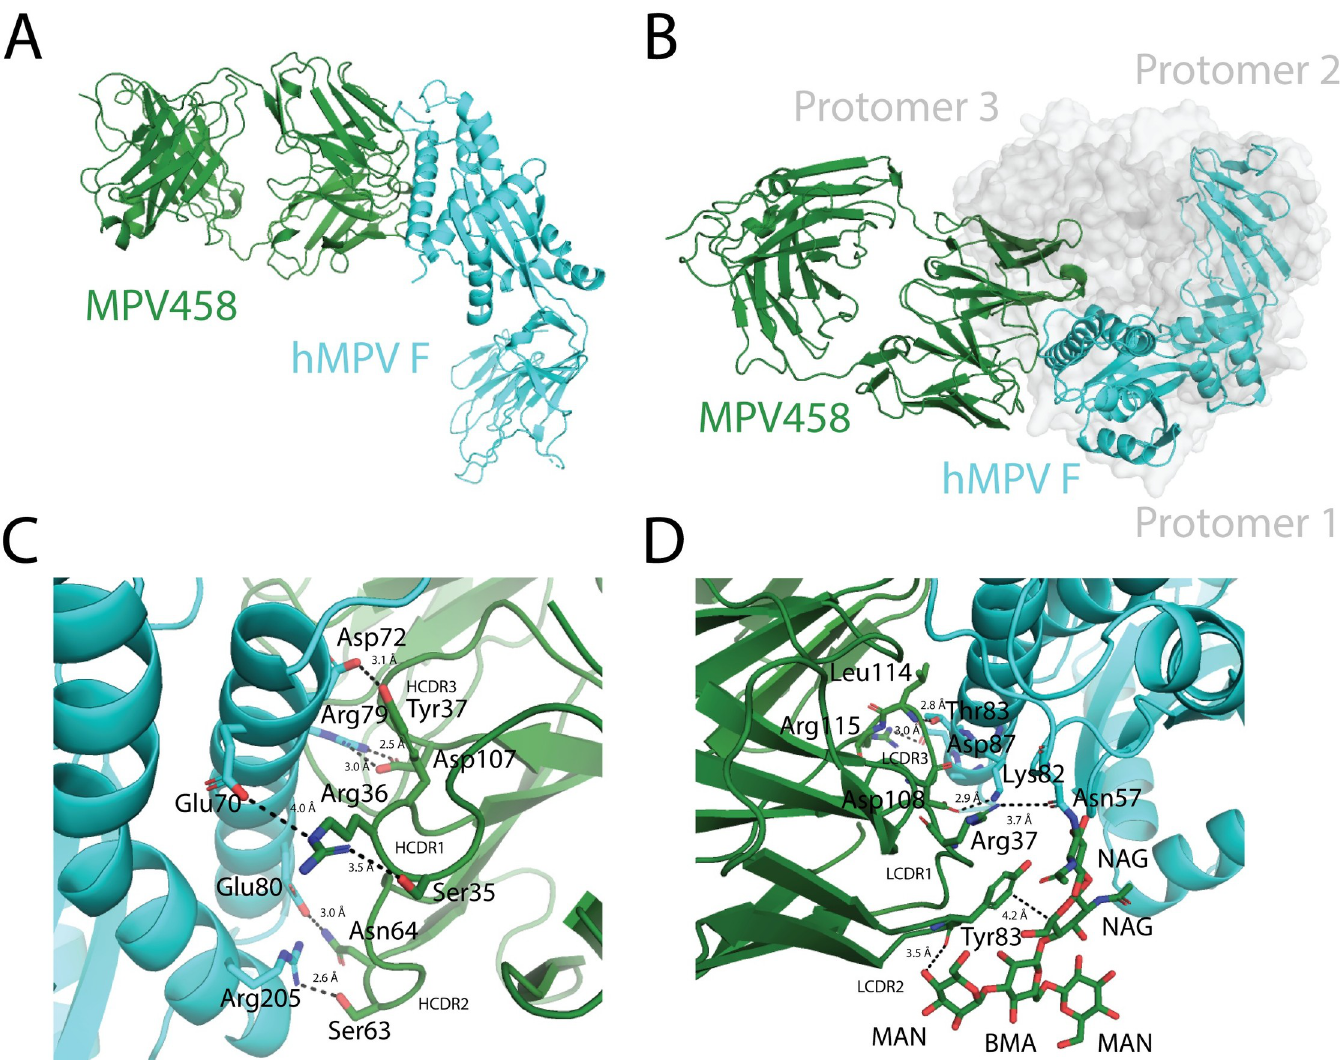
Fig 3. X-ray crystal structure of the hMPV B2 F + MPV458 Fab complex. (A) The asymmetric unit of the complex is displayed. Monomeric hMPV B2 F co-crystallized with one Fab of MPV458. (B) Overlay of the hMPV B2 F + MPV458 Fab complex with the previously determined X-ray crystal structure of hMPV A1 F in the pre-fusion conformation (MPV 115-BV, PDB: 5WB0). The hMPV F protein from each structure were overlaid in PyMol. MPV458 clashes with the trimeric structure. (C) Hydrogen bonding events observed between hMPV B2 F and the MPV458 Fab heavy chain. (D) Hydrogen bonding events observed between hMPV B2 F and the MPV458 light chain. The MPV458 light chain also interacts with an extended glycan patch linked from Asn57. CDR is complementarity determining region, FR is framework region. MPV458 numbering is in IMGT format.